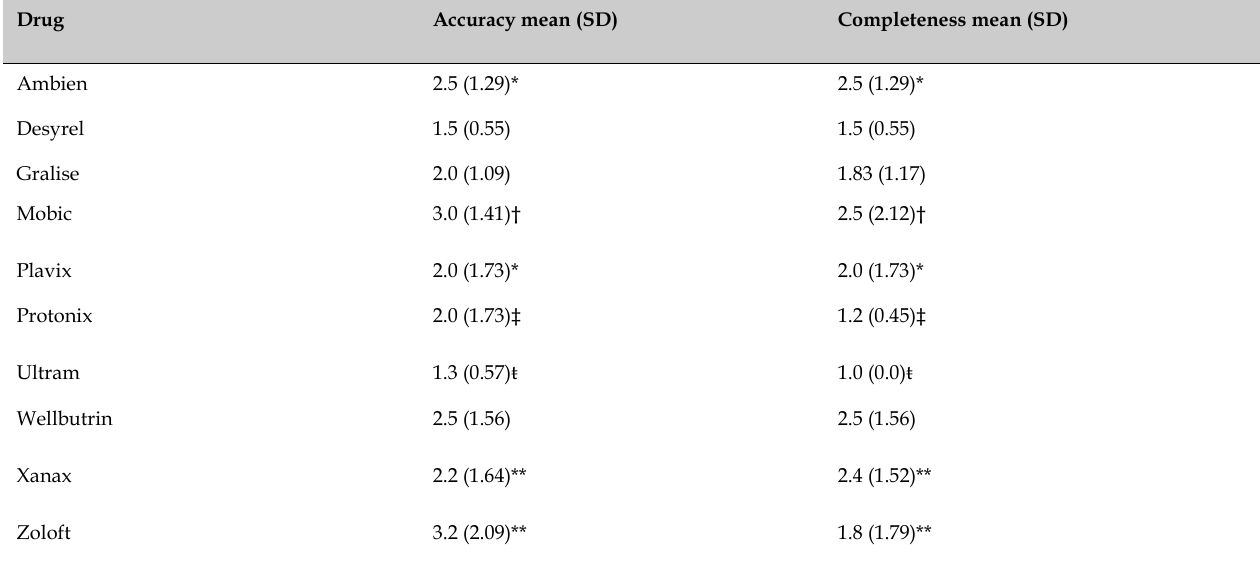
Table 2 Mean accuracy and completeness scores by drug